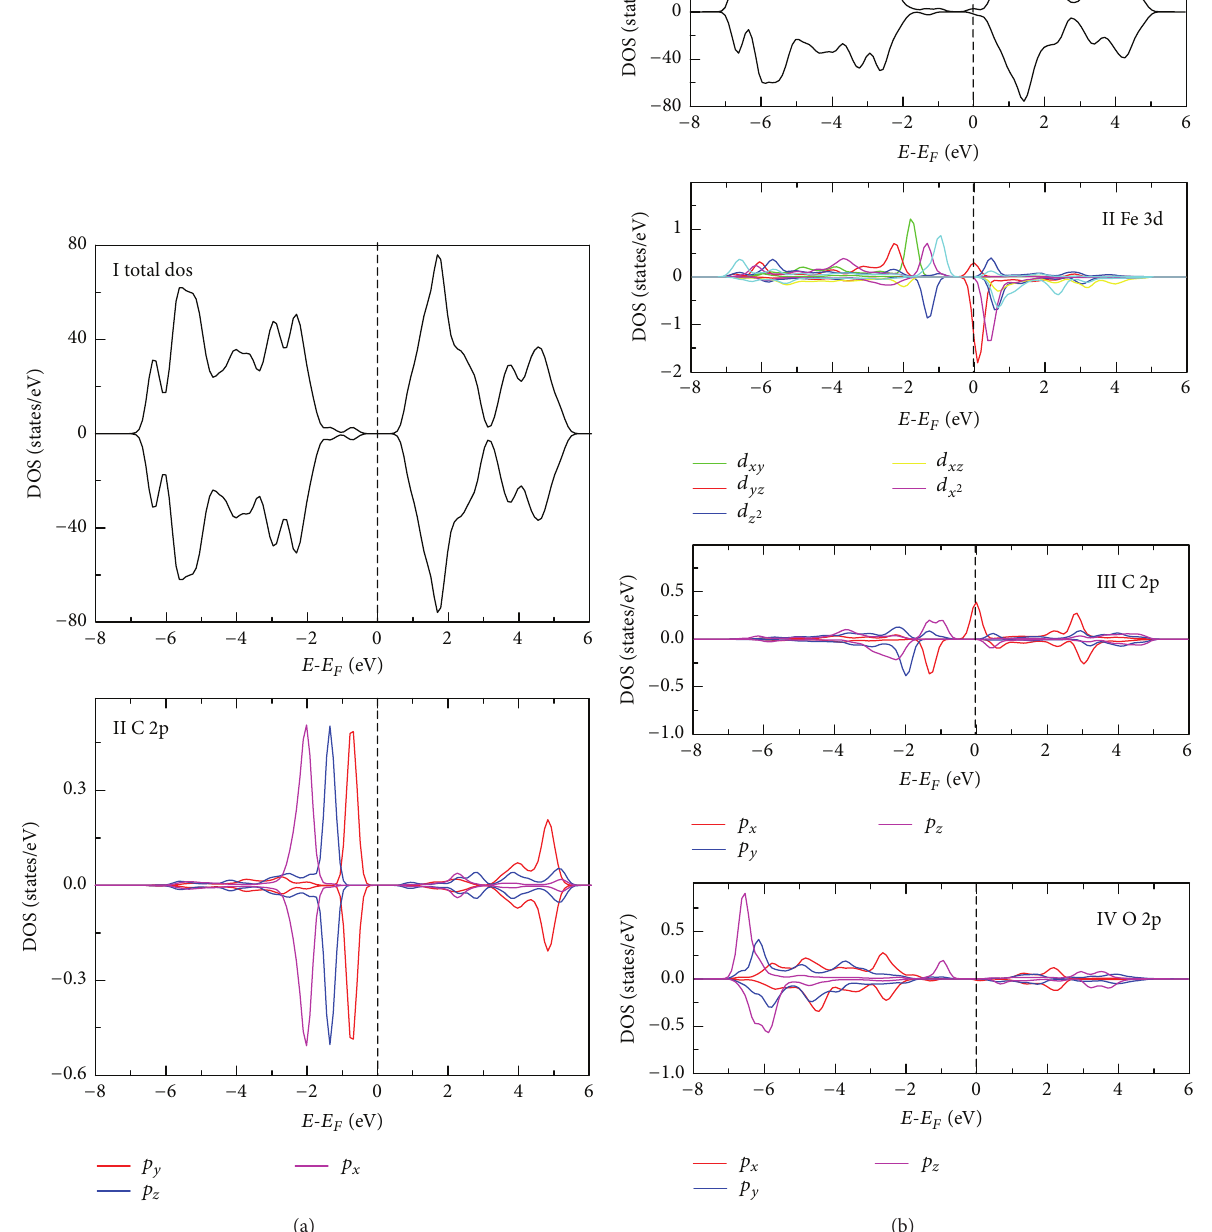
Figure 5: TDOS and PDOS for (a) V O -C codoped TiO 2 and (b) V O -Fe-C codoped TiO 2 .